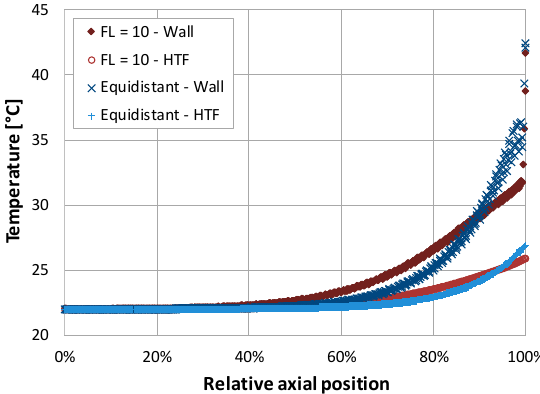
Figure 9. Heat transfer fluid (HTF) and wall element center temperatures of two distributions at 6300 s physical time.